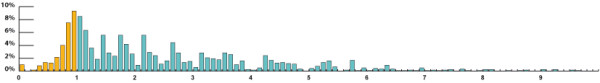
Frequency distribution of the ratio between average retrieval precision and a-priori probability value relative to the group of atypical nevi. The analysis has been performed considering the first 12 retrieved images. The average retrieval precision is the ratio of the relevant atypical nevi retrieved images to the total retrieved ones, and the a-priori probability the a-priori probability is the percentage of the atypical nevi with respect to the total number of the archive images.